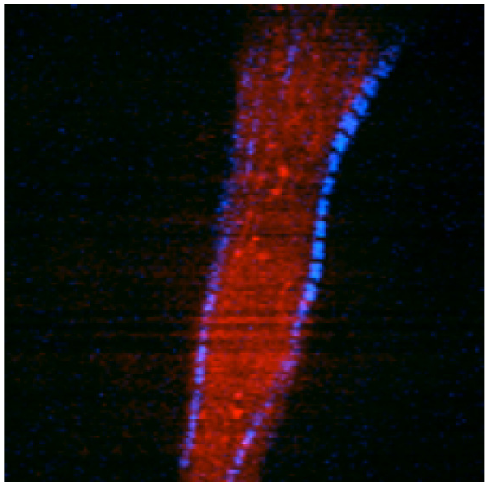
Fig. 5. Simultaneous SHG (blue) and CARS (red, 1446 cm (cid:1) 1 ) signals measured on cardiomyocyte cells, displaying the mem- brane of the cell and its inner structure (respectively).